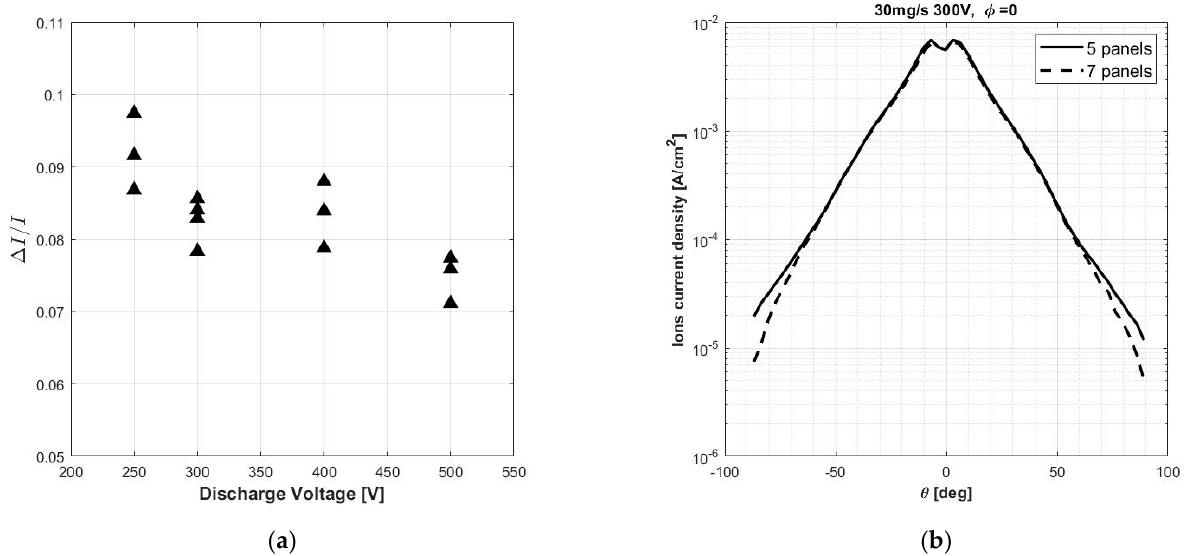
Figure 11. Variations of the discharge current as a function of the discharge voltage for the HT20k M configuration ( a ). Beam current density distribution for the for the Faraday probe at 𝜑 = 0° for 𝑚(cid:4662) (cid:3028) = 30 mg/s and 𝑉 (cid:3031) = 300 𝑉 with 5 and 7 cold panels ( b ).